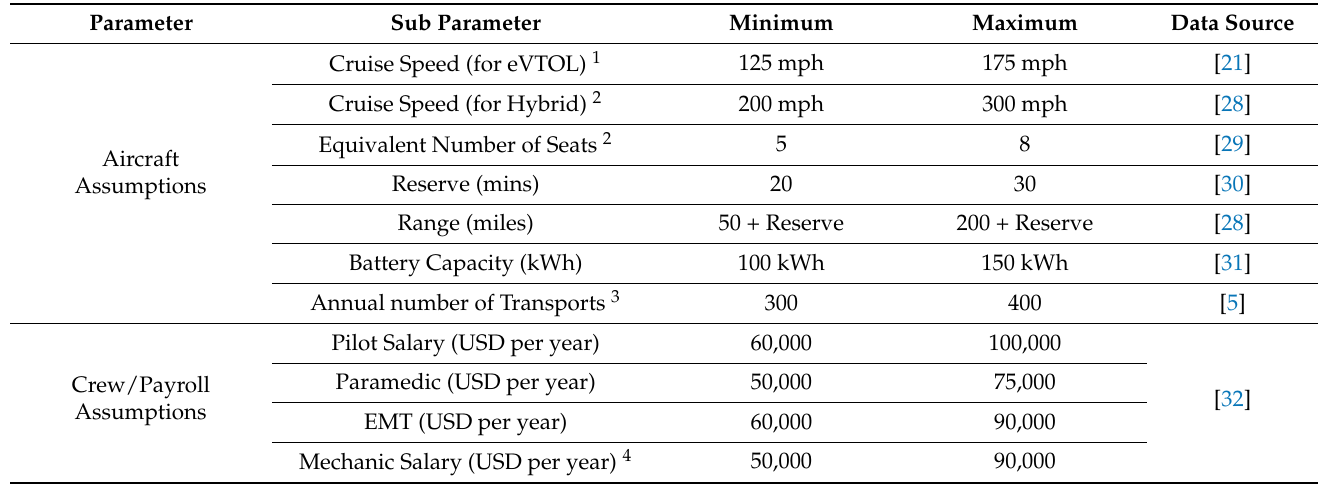
Table 3. Key operational assumptions.